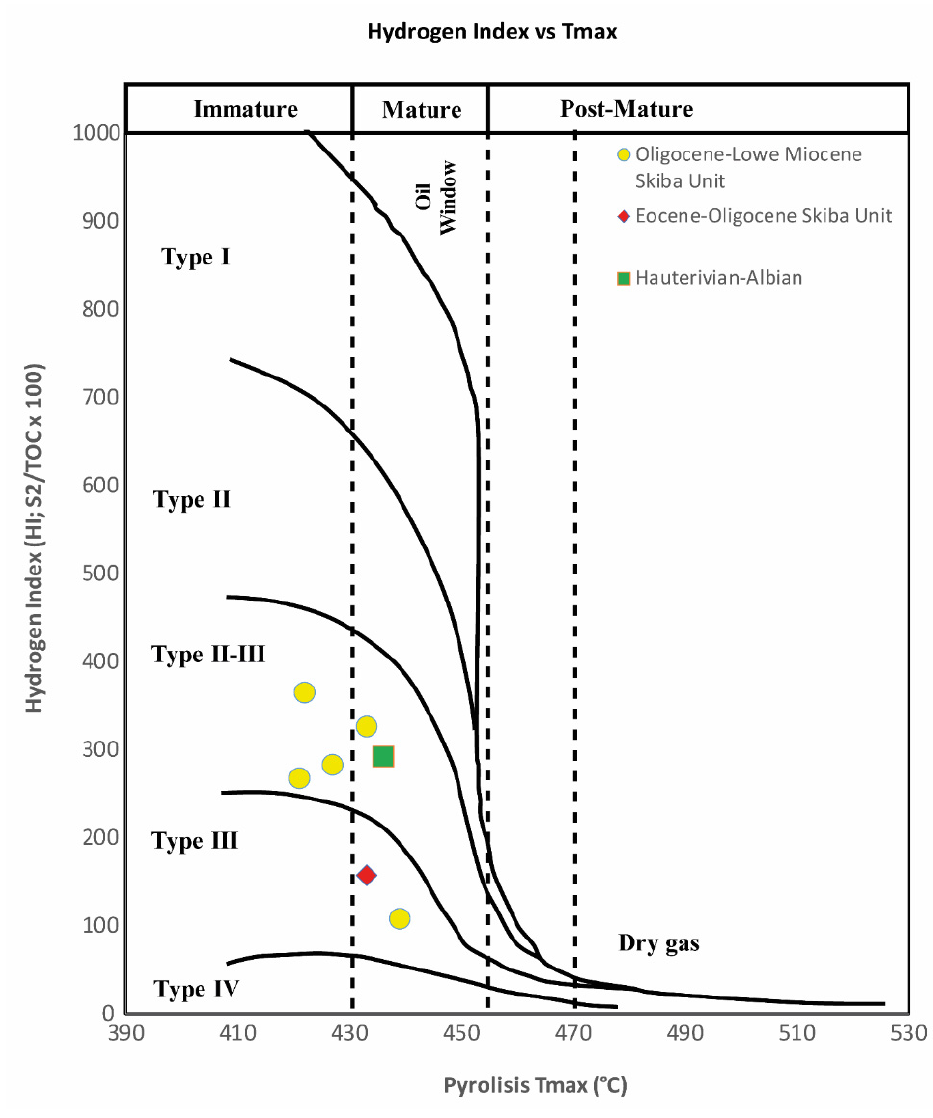
Figure 3. Kerogen classification of the studied samples according to pseudo Van Krevelen diagram, where Tmax vs. HI derived from Rock-Eval Pyrolysis are plotted (redrawn after [62]). As shown in Table 2 and Figure 3, the Rock-Eval results indicate type II - III kerogen. TOC and HI, ranging between 0.58 and 11.29% and 108 and 365, respectively, are typical of good to excellent source rocks. The highest TOC and HI values characterise pelites and black shales from the Krosno Beds and Lower Cretaceous Shypot formation (Chornogora Unit). Tmax values range between 421 ◦ C and 439 ◦ C indicating roughly the immature and the early stages of HC generation.